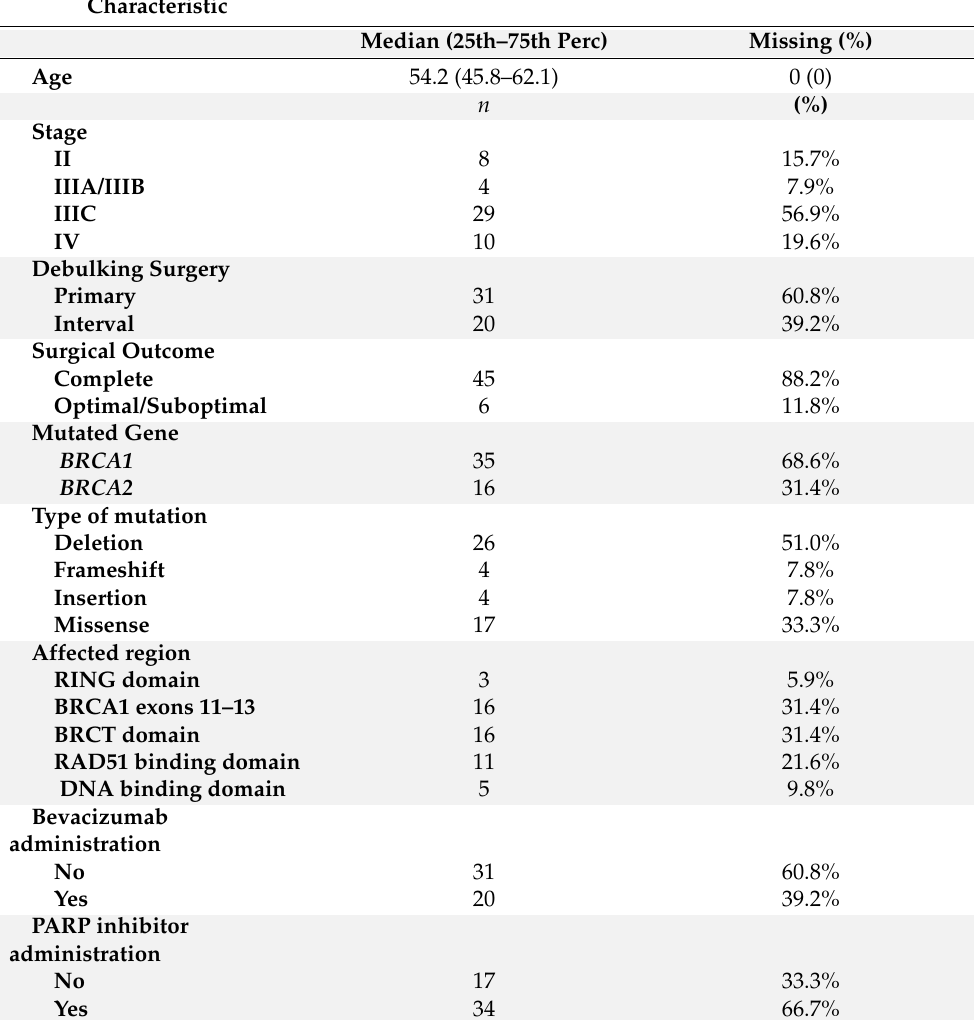
Table 1. Clinical, genetic, and treatment characteristics of BRCA1/2 -mutated serous ovarian can- cer